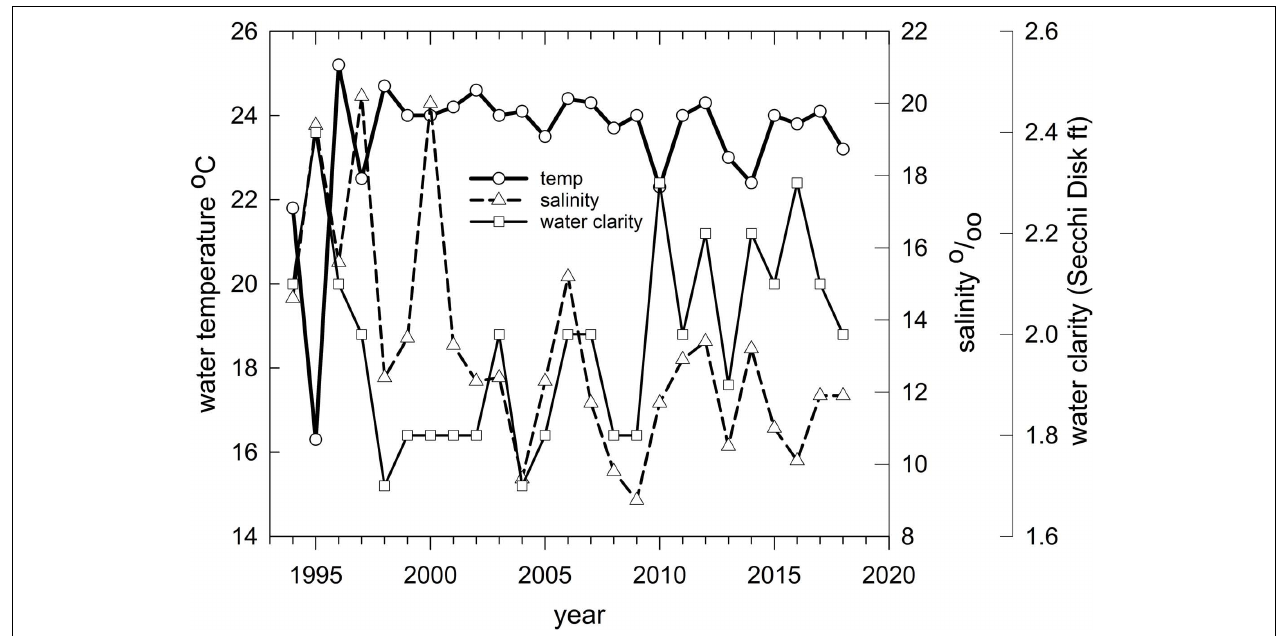
FIGURE 8 | Mean water temperature ( ◦ C), clarity (Secchi disk reading in feet) and salinity (parts per thousand) for Barataria Bay trawl stations sampled by the Louisiana Department of Wildlife and Fisheries, 1994–2018.